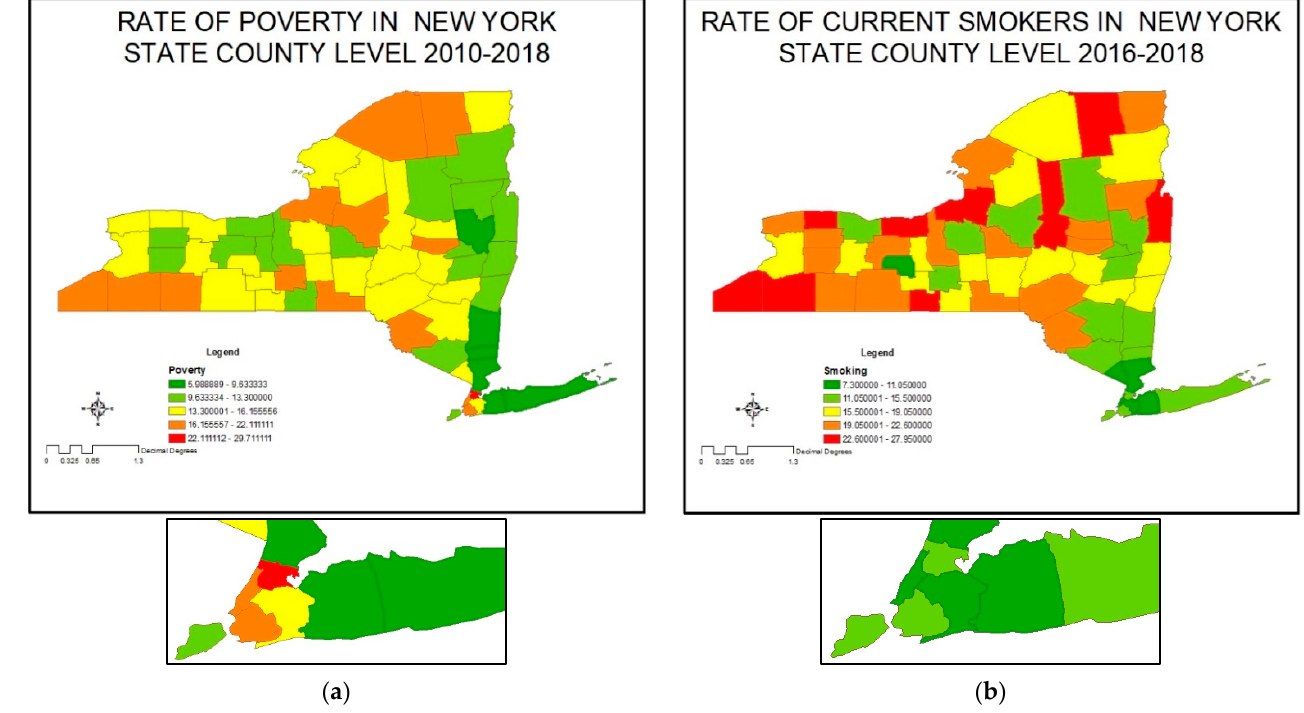
Figure 3. Rate of poverty and smoking in New York State by county: ( a ) poverty; ( b ) smoking.